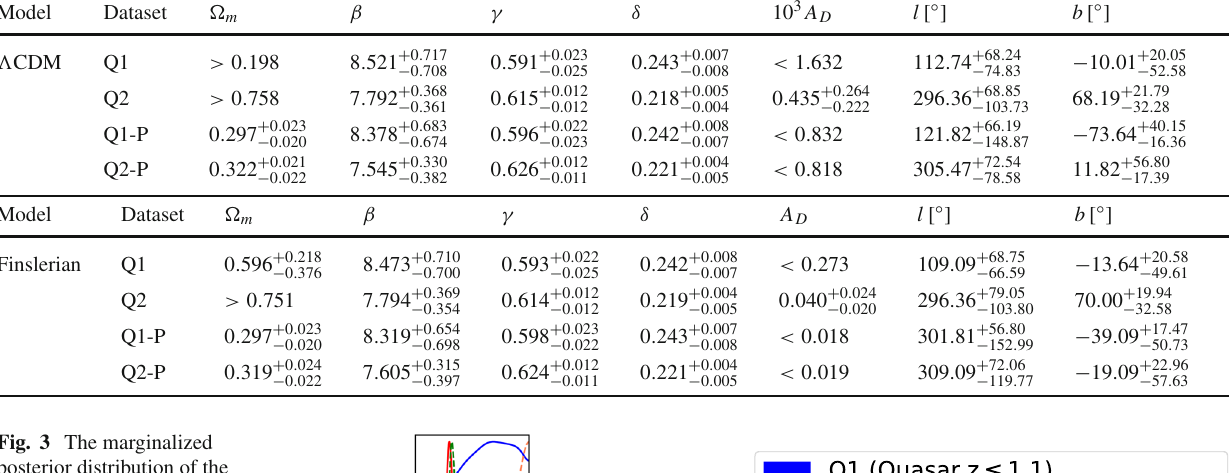
Fig. 3 The marginalized posterior distribution of the parameters in the dipole-modulated (cid:2) CDM model. The blue lines denote the results from dataset Q1, the orange lines denote the results from dataset Q2, the red lines represent the results from dataset Q1-P, and the green lines represent the results from dataset